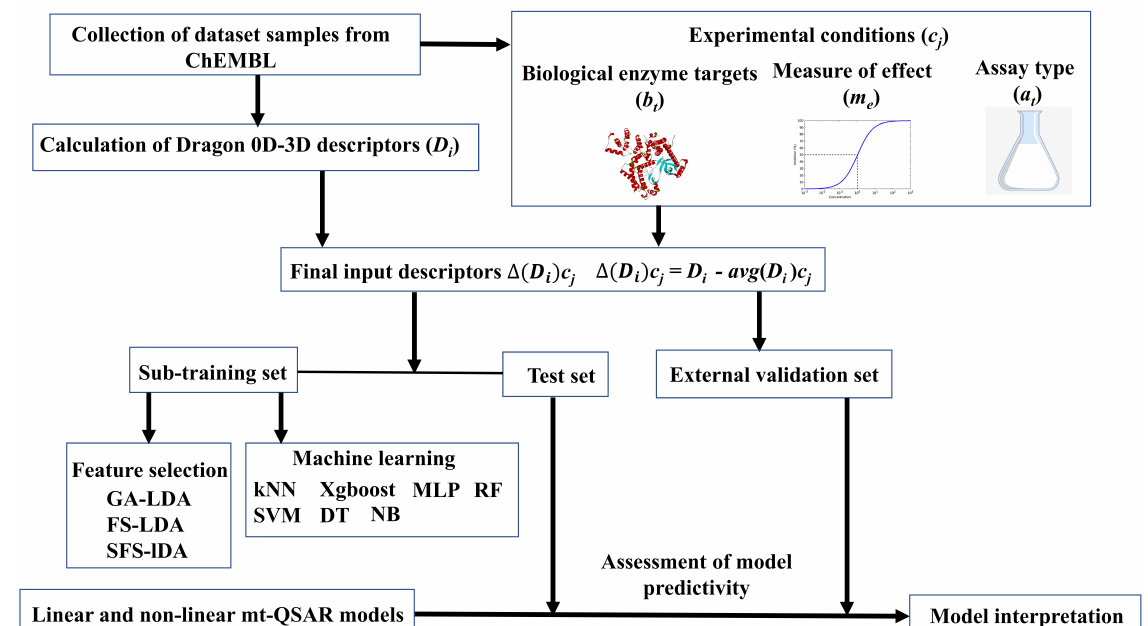
Figure 1. Flowchart showing the multi-target Quantitative Structure-Activity Relationships (mt-QSAR) work performed in the current